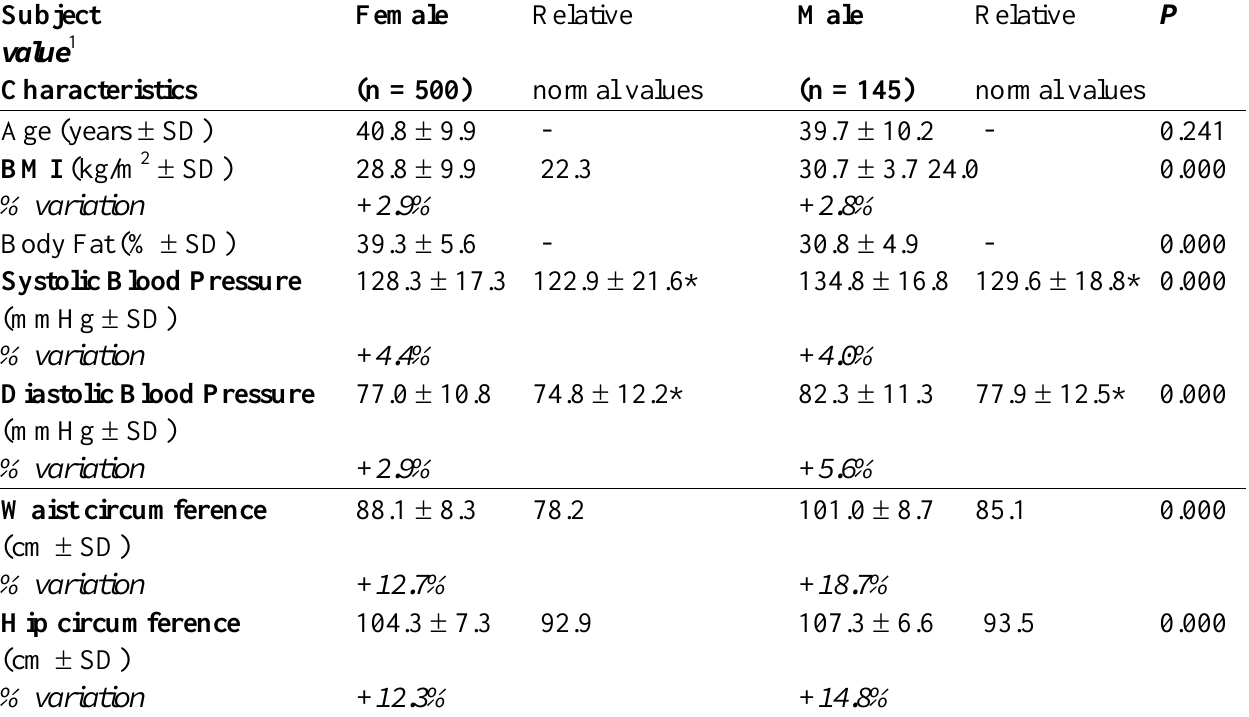
Table 1. Subject characteristics at program